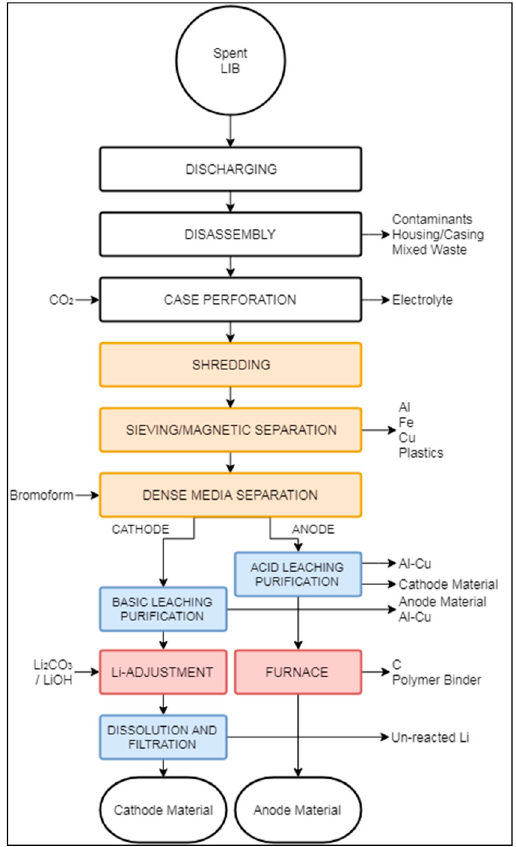
Figure 10. Schematic representation of the OnTo recycling process.